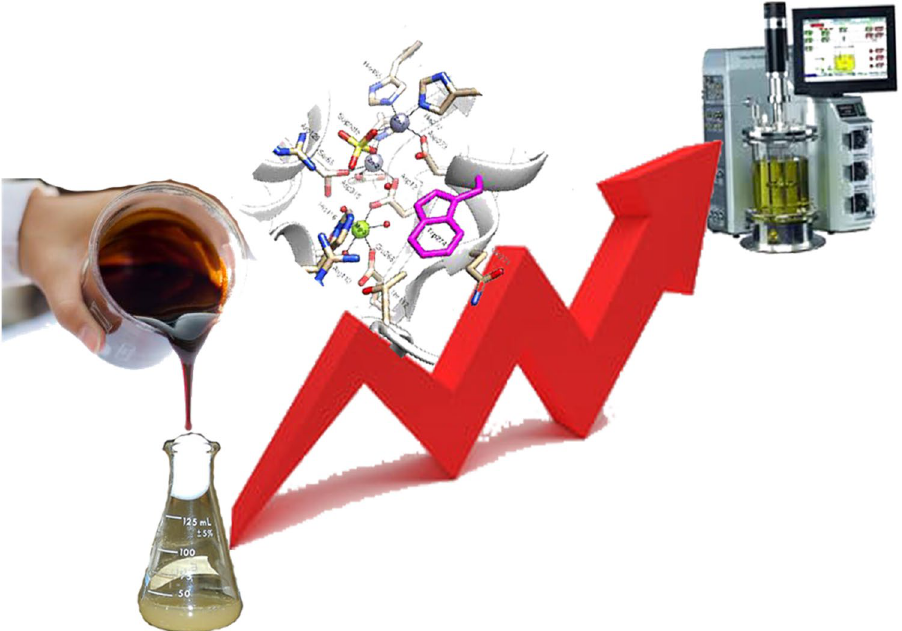
Figure 1. Schematic illustration of the exploitation of green chemistry sustainable strategies for the ultimate benefit of biowaste sugarcane molasses for the scale-up production of bacterial ALP on bench top-scale